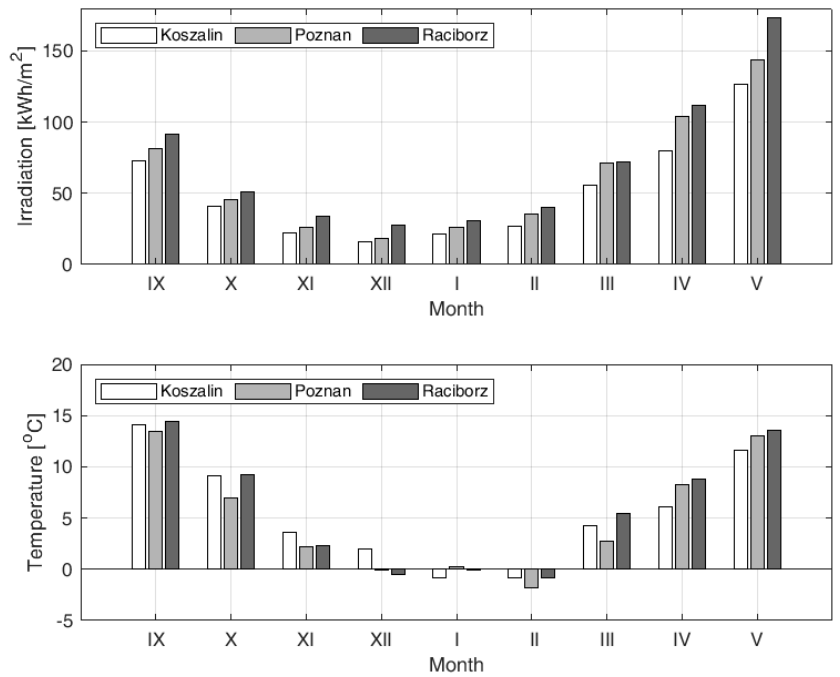
Figure 2. The irradiation on a horizontal plane (top graph) and average outdoor temperature (bottom graph) in particular months of the heating season.